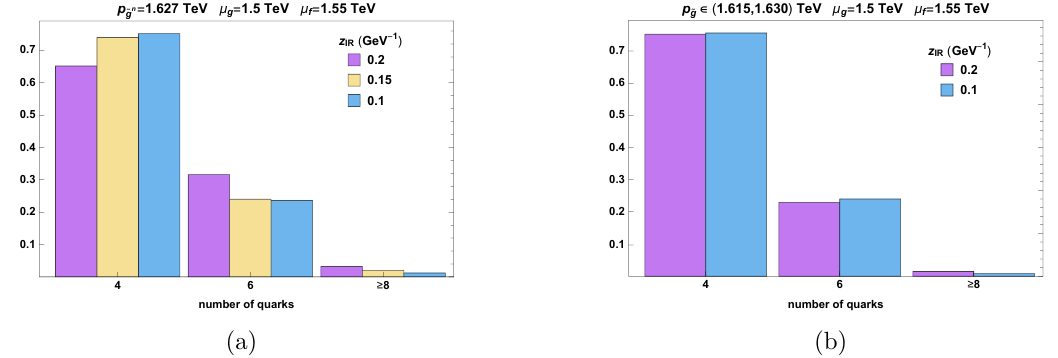
Figure 15. Normalized distributions of number of light quarks emitted in the decay of a pair of KK gluinos (a) and KK gluinos in an energy window (b) for di(cid:11)erent choices of z IR . On the right panel the number of KK modes contained in the chosen energy window is one (three) for z IR = 0 : 1GeV (cid:0) 1 (0.2 GeV (cid:0) 1 ).